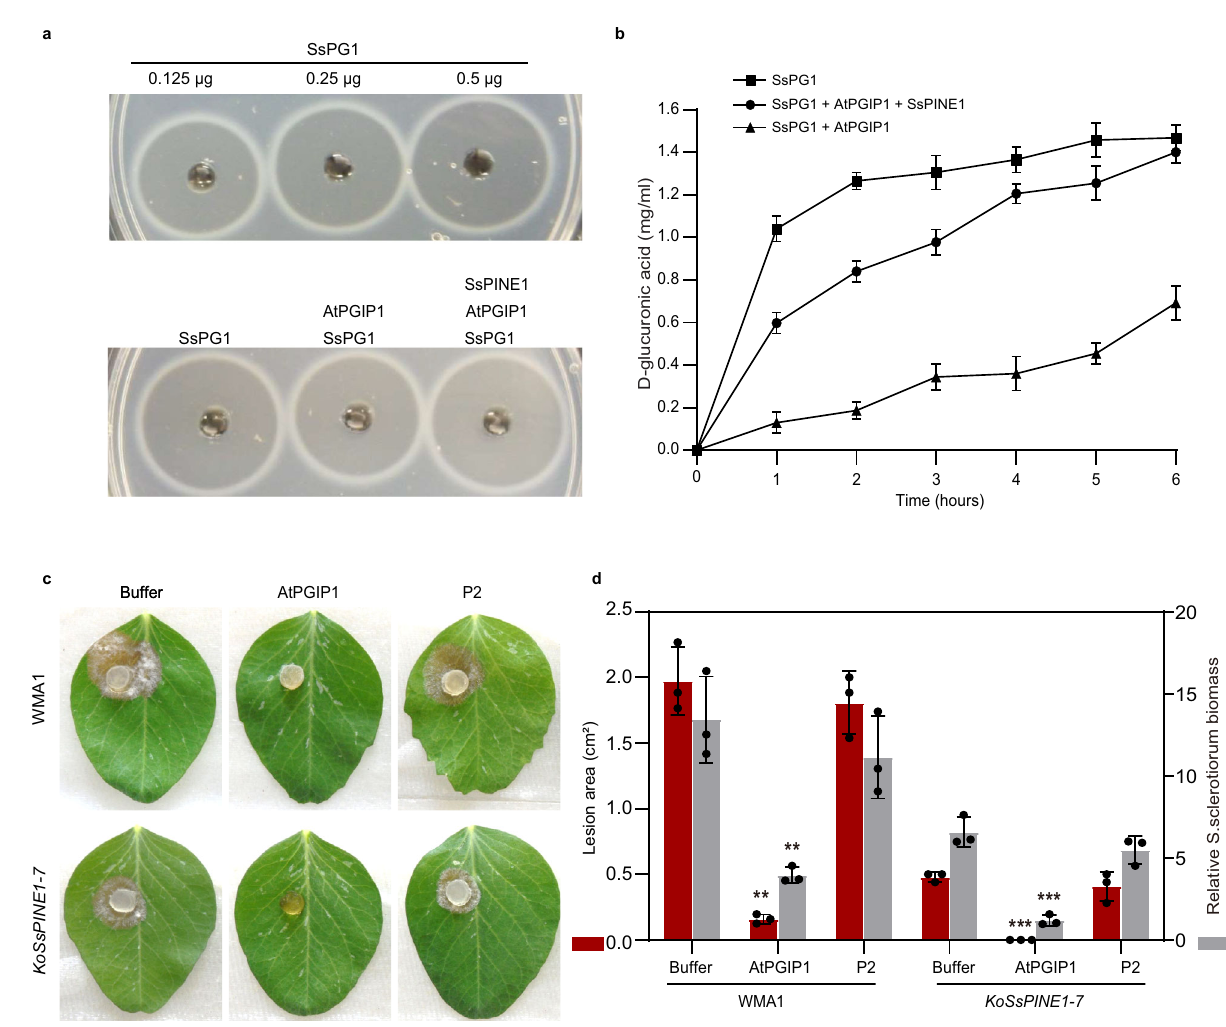
Fig. 4 AtPGIP1 inhibits SsPG1 hydrolytic activity and Sclerotinia infection, whereas SsPINE1 nulli fi es AtPGIP inhibition. a PG activity (ring diameter) is proportional to SsPG1 concentration (top panel), and addition of AtPGIP1 (10 μ g) to SsPG1 (0.5 μ g) reduced its PG activity and further addition of SsPINE1 (10 μ g) negated the inhibition effect of AtPGIP1 and restored PG activity of SsPG1 (bottom panel). b PG activity of SsPG1 (0.5 μ g) alone, in the presence of AtPGIP1 (10 μ g) or in the presence of both AtPGIP1 and SsPINE1 (10 μ g each) was determined using the DNSA method by measuring accumulation of D-galacturonic acid. Data represent means ± s.d. of n = 3 independent replicates. c Puri fi ed AtPGIP1 protein inhibited Sclerotinia infection. AtPGIP1 protein (10 μ g) and its mutation variant AtPGIP1-P2 (10 μ g; see Fig. 5) were applied to Sclerotinia sclerotiorum inoculum of wildtype strain WMA1 and SsPINE1 - deletion mutant KoSsPINE1-7 in detached pea leaf bioassays with PBS buffer as a control for comparison. Representative photos (2 dpi) are presented. d . Lesion area and relative biomass of S. sclerotiorum wildtype strain WMA1 and SsPINE1 -deletion mutant KoSsPINE1-7 in the presence of AtPGIP1 (10 μ g), AtPGIP1-P2 (10 μ g) or PBS buffer 2 dpi. Biomass was measured by genomic DNA quantitative PCR. Data represent means ±s.d. with n = 3 biological replications. Treatment means are signi fi cantly different from that of the PBS buffer control at P < 0.01 (**) or 0.001 (***), respectively, in two-tailed t test. The experiment was performed twice with similar results obtained. Source data are provided as a Source data fi